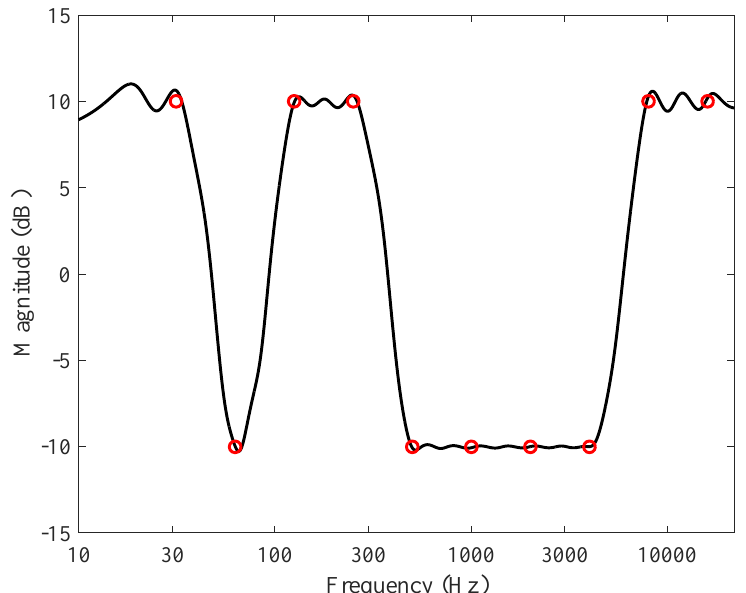
Figure 11. Magnitude response of an optimized parallel graphic equalizer, when command gains (red circles) at octave bands are set to either 10dB or − 10dB.